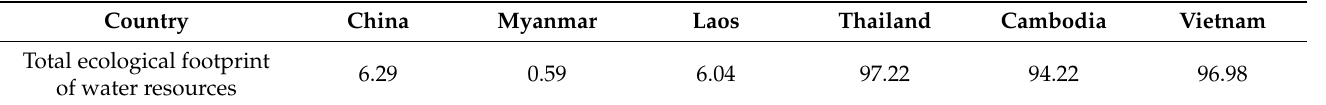
Table 5. Ecological footprint of water resources in LMRB unit: 10 6 hm